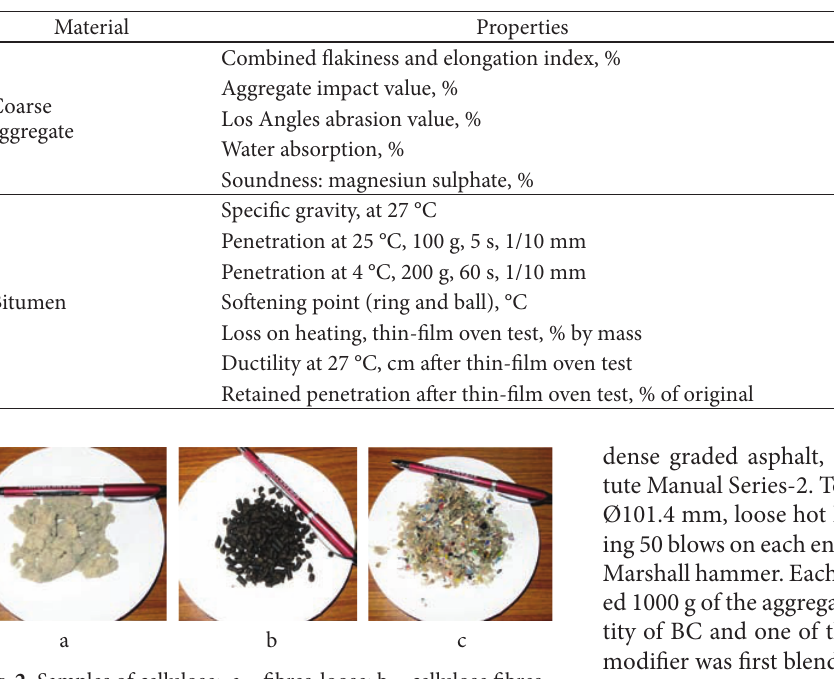
Fig. 2. Samples of cellulose: a – fi bres-loose; b – cellulose fi bres- pellets; c –